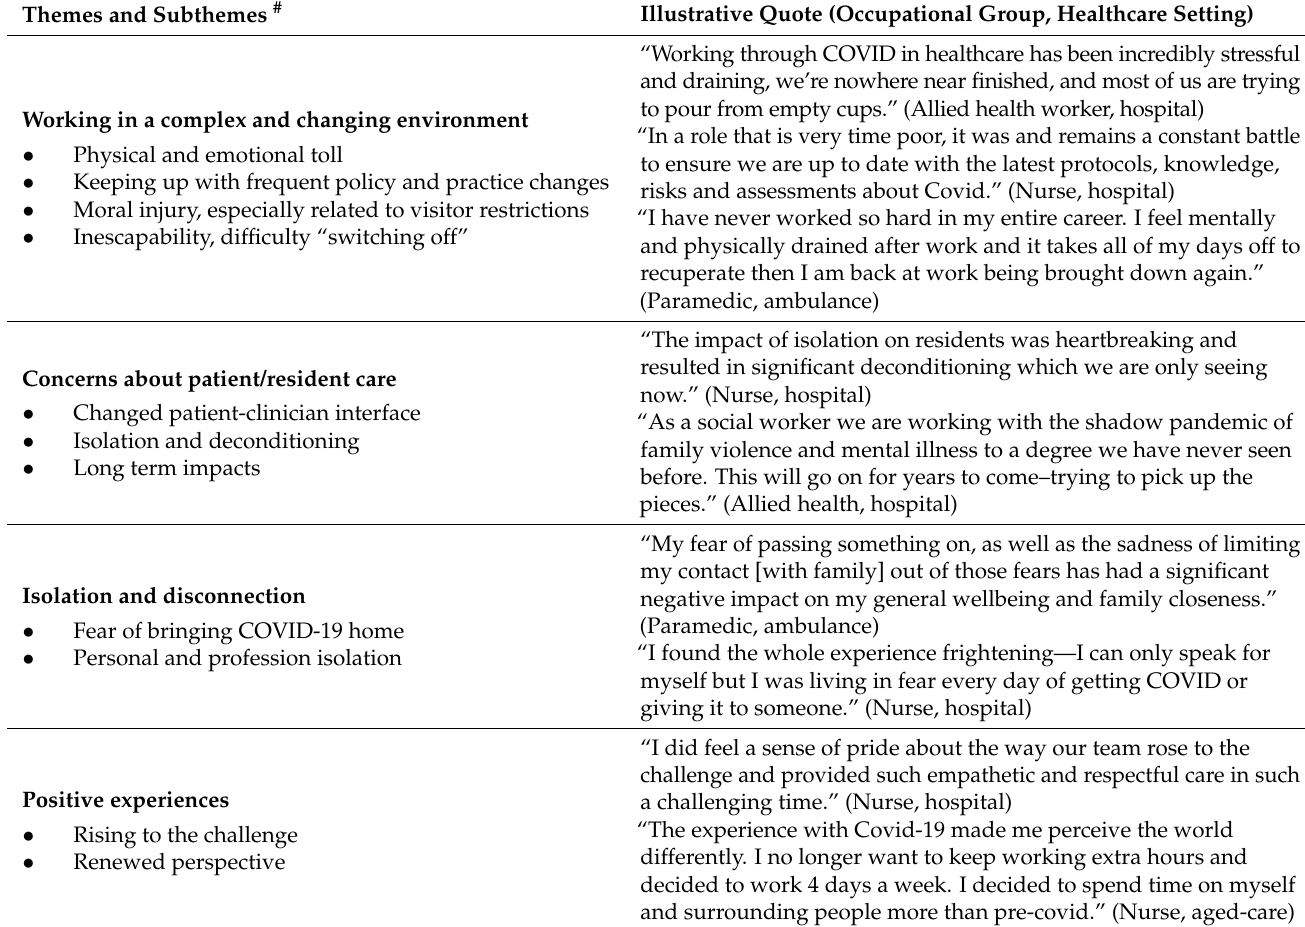
Table 4. HCW experiences of the pandemic—dominant themes, sub-themes, and illustrative quotes from analysis of free-text